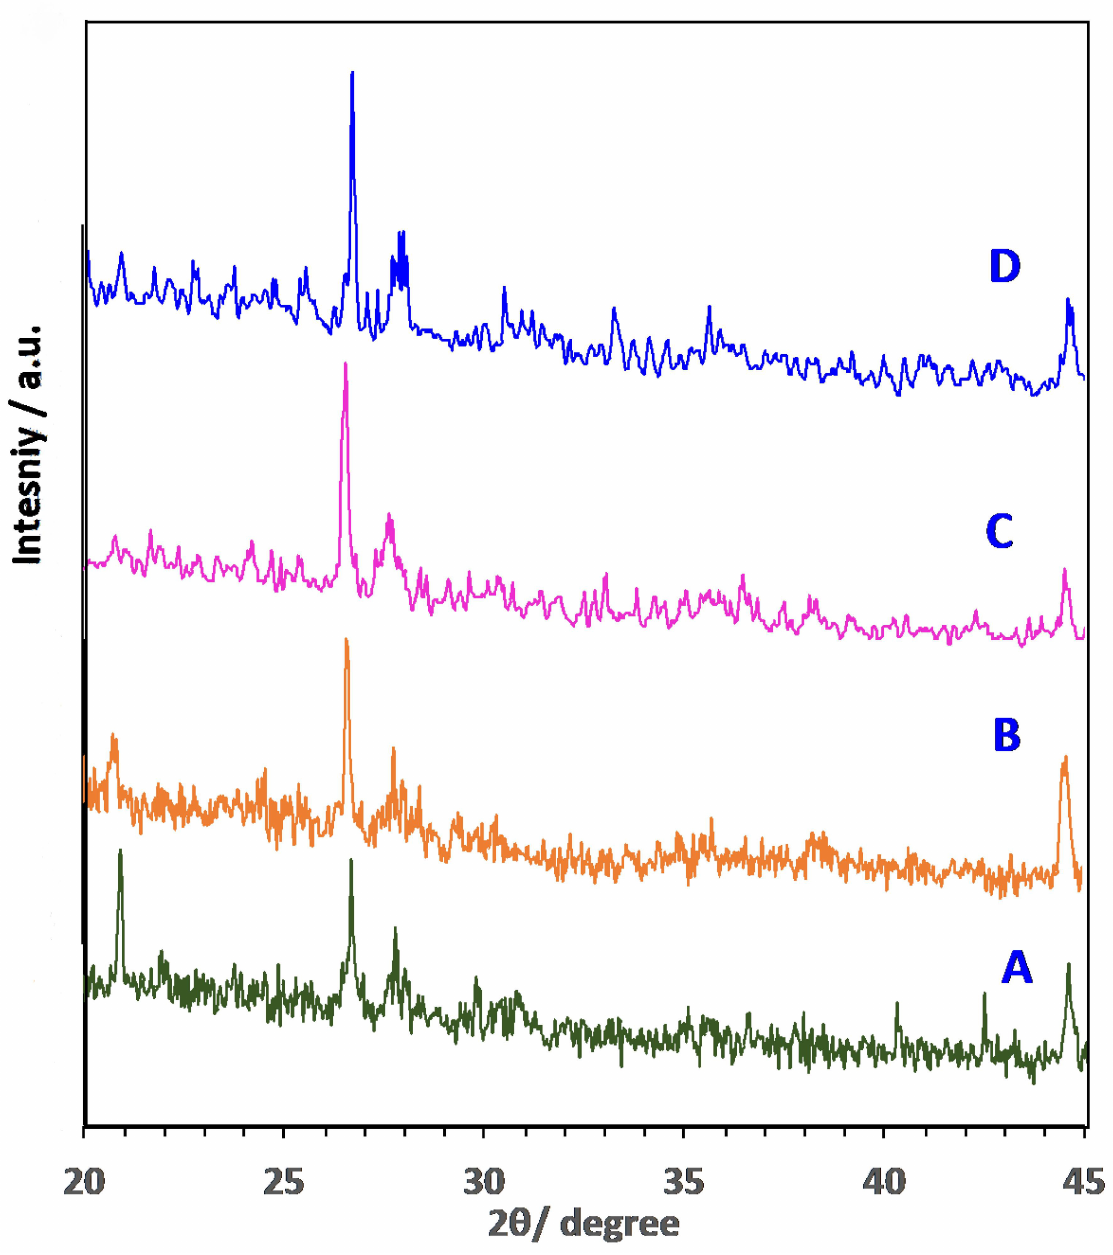
Figure 4. XRD diffraction pattern of AS adsorbent substances: ( A ) AS; ( B ) AS400; ( C ) AS600 and ( D )